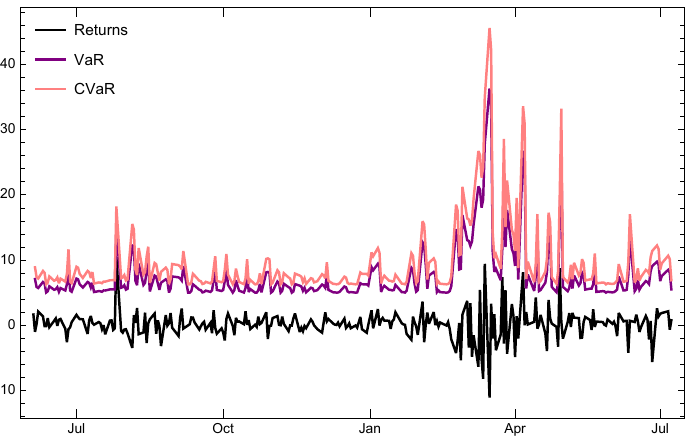
Figure 7. Results of risk comparisons (based on the Laplace distribution) by the pre-determined confidence level α = 99% for the NASDAQ:GOOG. The horizontal and vertical axes stand for the time and risk values and returns,